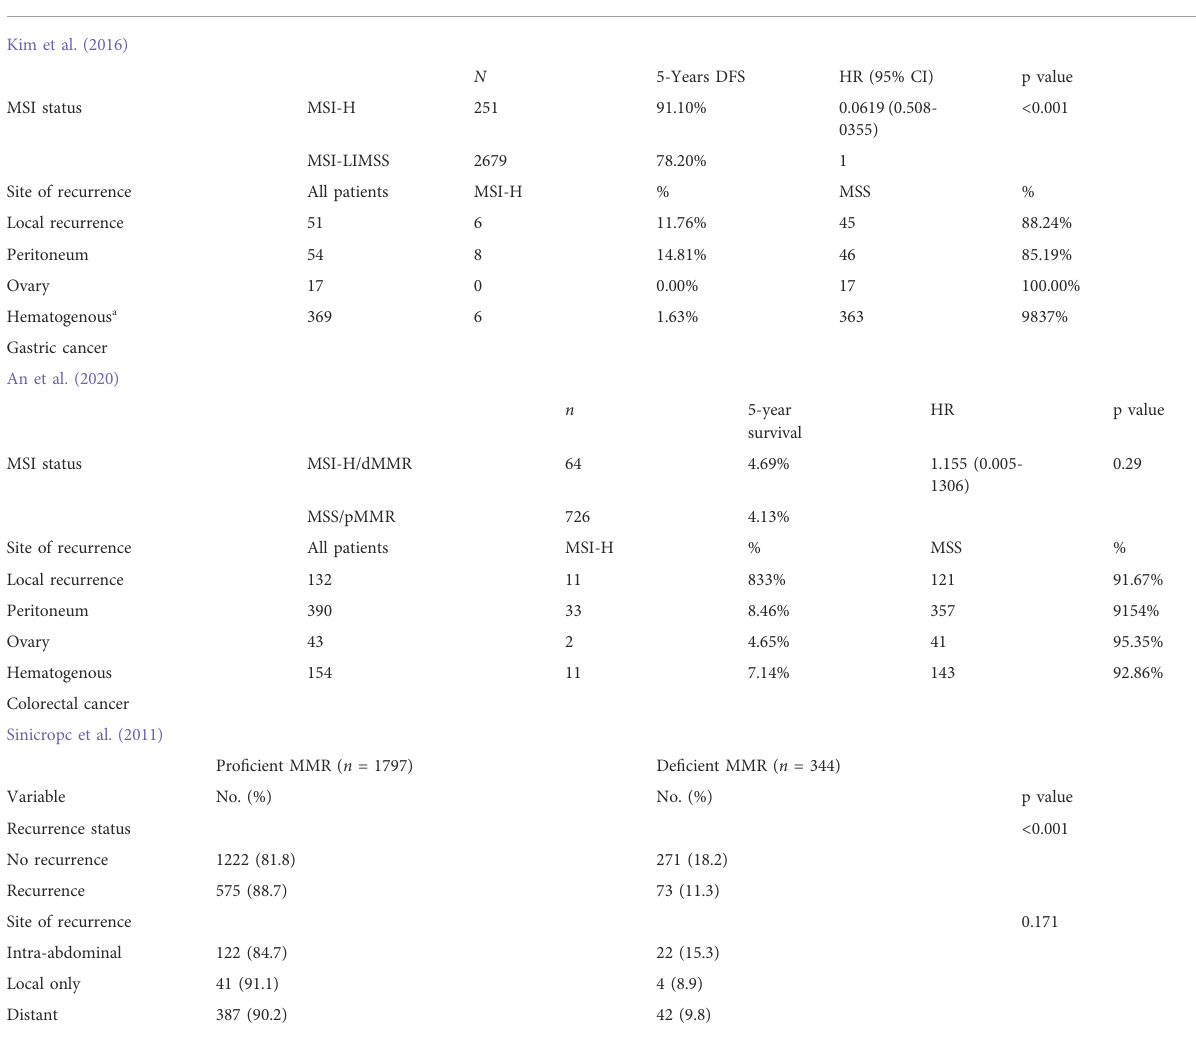
TABLE 2 Sites of recurrence for early-stage MSI-H colorectal and gastric cancers. Colorectal